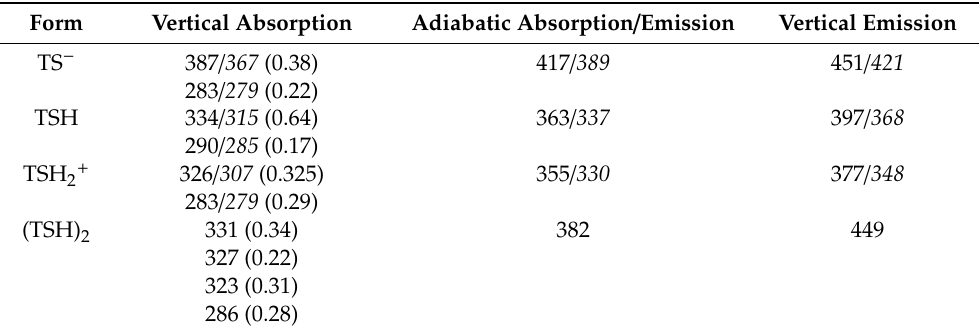
Table 3. Predictions for low-lying excited states of various forms of the TS molecule in water. Energetics given in nm scale, dimensionless oscillatory strengths for the absorption process given in parentheses, SS approach-based energies given in italics. Intense absorbing states and the lowest (emitting) state reported.